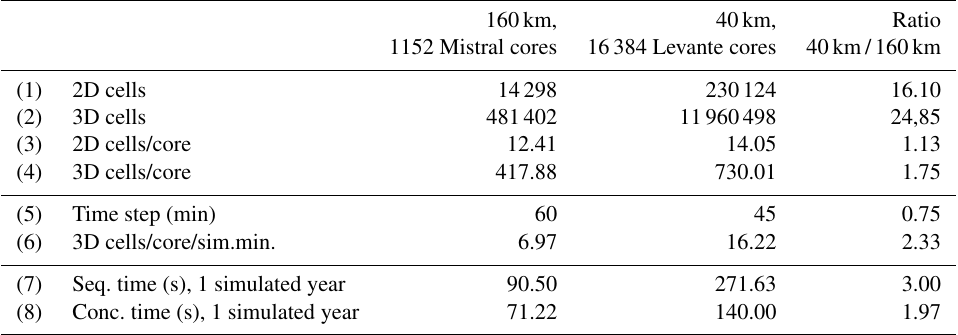
Table 3. Detailed numbers for the two experiments selected from the two setups of 160 and 40km. The description is provided in the text. A total of 1152 Mistral cores correspond to 32 nodes, while 16384 Levante cores correspond to 128